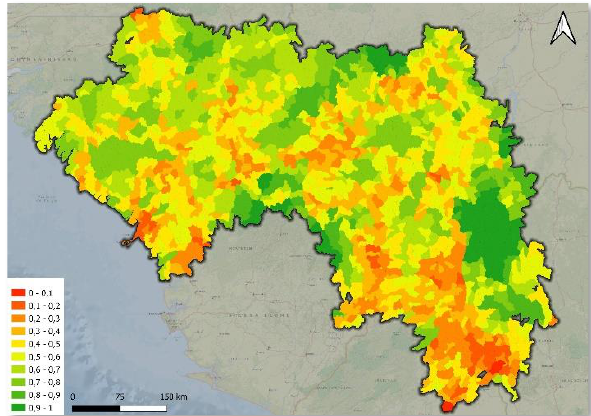
Figure 6. Map of the Landscape Fragmentation Indicator, by SELU –data in 2005